Question: Condense the content of this figure into a single sentence.
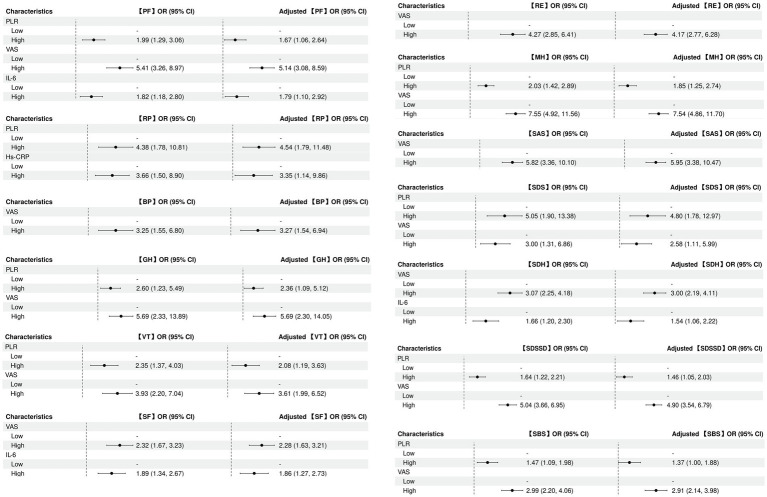
Answer: Logistic regression analysis of the SPP indicators using separate PLR and separate VAS separately.